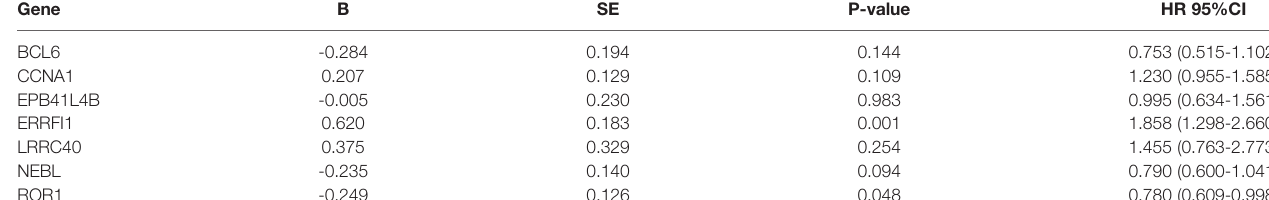
TABLE 3 | Multivariate cox analysis of